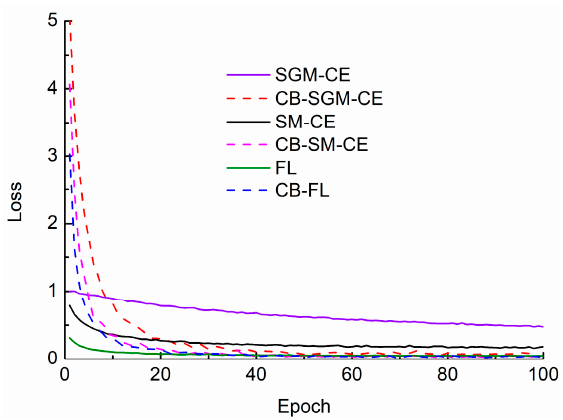
Figure 4. Loss curve for validation set using different loss functions.